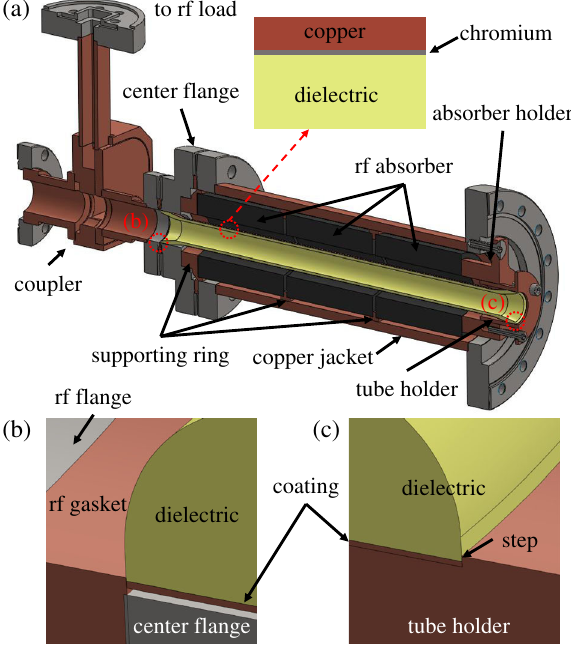
FIG. 8. (a) Cross-section of the entire power extractor/transfer structure assembly with details of the 3-layer metallic coating of the dielectric tube. (b) Magnified view of the contact between the dielectric tube and the rf gasket at the beam exit. (c) Magnified view of the contact between the dielectric tube and the tube holder at the beam entrance.